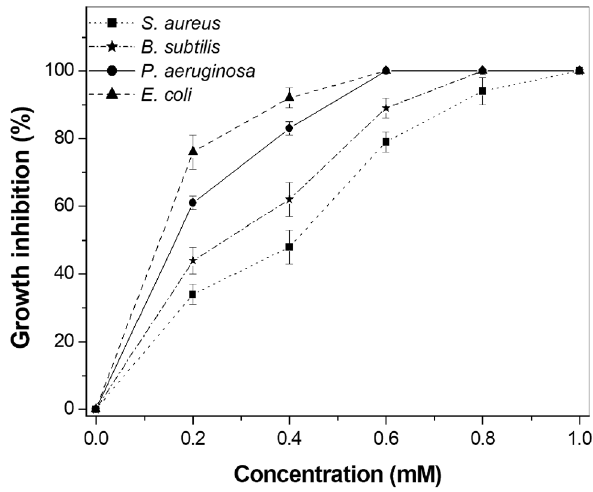
Figure 4. Antimicrobial activity of ZnO NPs determined by